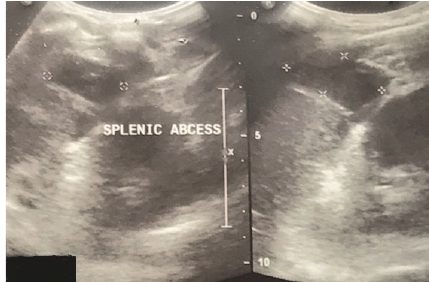
Figure 1: Ultrasound of the abdomen showing multiple hypoechoic splenic and perisplenic collections.